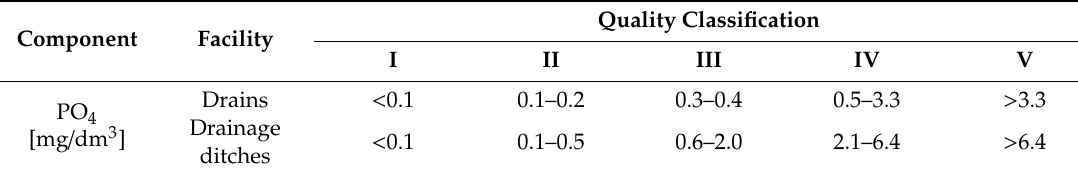
Table 1. Drainage waters quality classification ranges in Poland